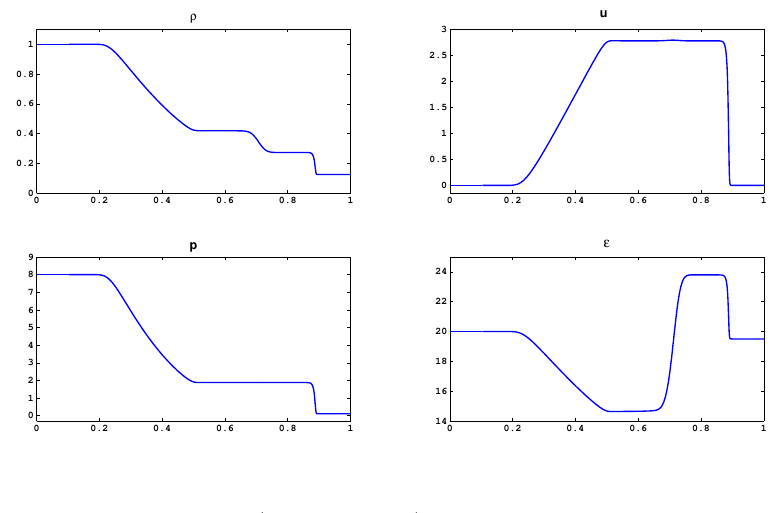
Figure 1. Test 1 (the stiffened gas): the space graphs at time t fin = 0 . 075. 2. The classical Van der Waals gas state equations in the form (3.7)